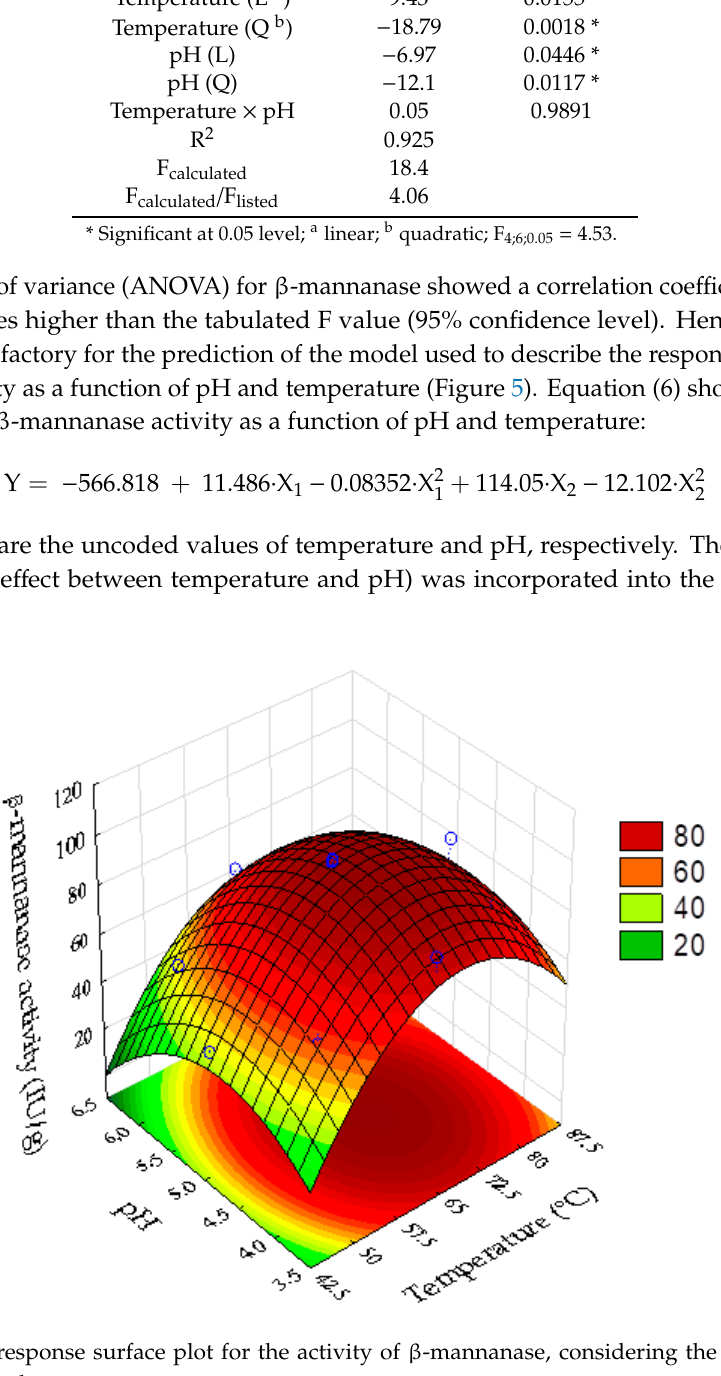
Figure 5. 3D response surface plot for the activity of β -mannanase, considering the e ff ects of the variables pH and temperature.